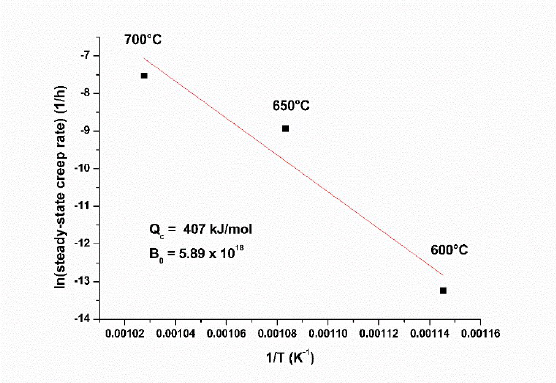
Figure 14. The diagram to calculate the activation energy ( Q c) at 500 MPa of the Inconel 625 alloy. The value of core diffusion activation energy ( Q (core) ) for Nickel reported from Frost and Ashby